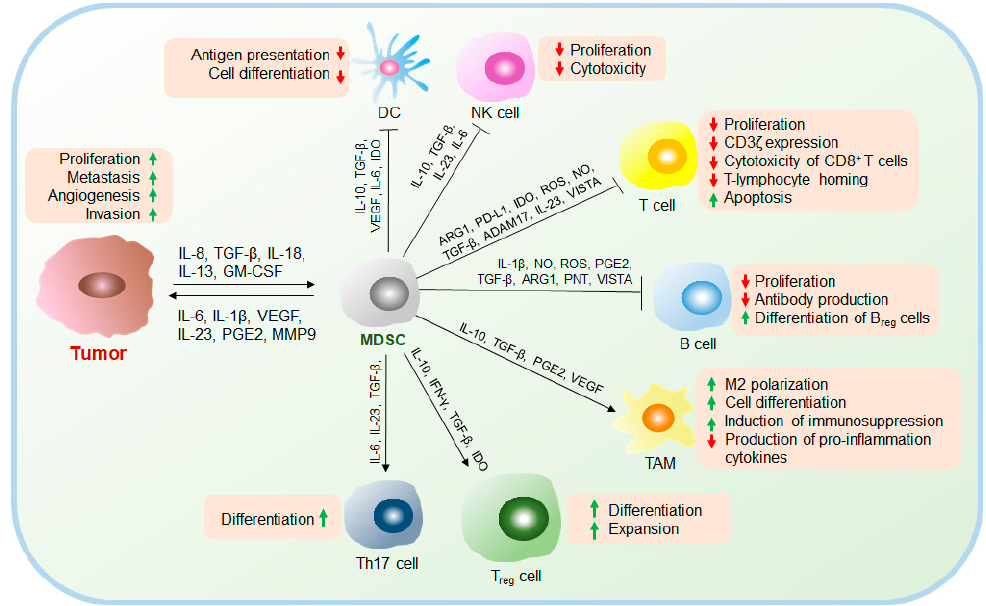
Figure 2. Multiple mechanisms of immunosuppression mediated by MDSCs in the TME. MDSCs secrete a large number of cytokines to remodel the TME by accelerating tumor development, angiogenesis, and metastasis; inhibiting the antitumor response mediated by T cells, B cells, NK cells, and DCs; and promoting the differentiation of immunosuppressive TAMs, T regs , and Th17 cells. NK cells, natural killer cells; T regs , regulatory T cells; B regs , regulatory B cells.